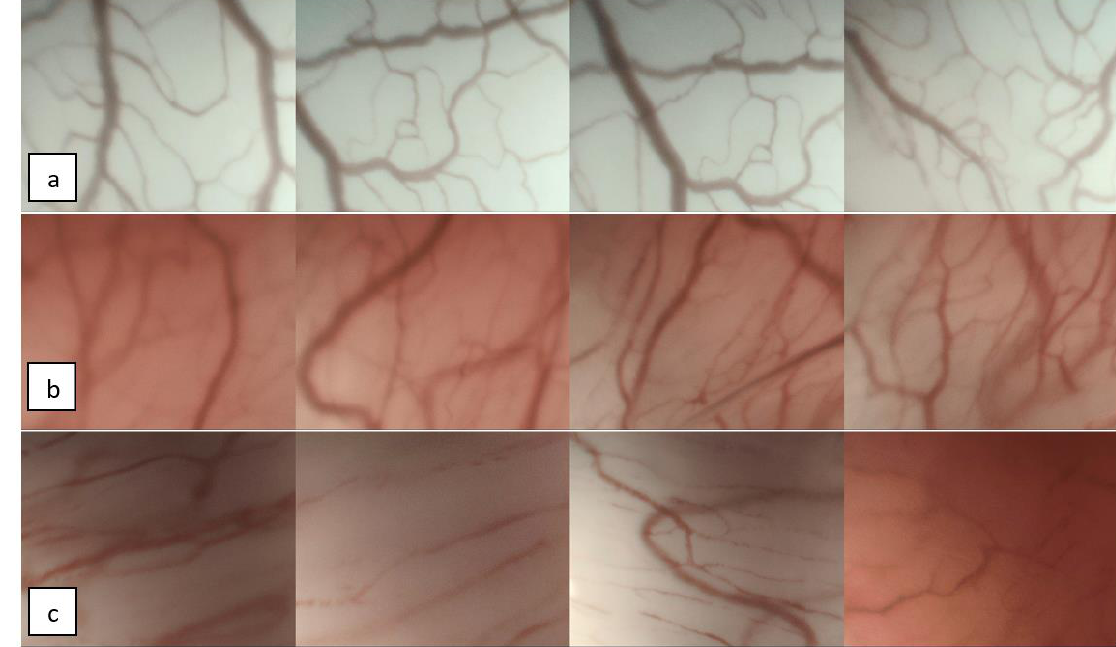
Figure 2. Examples of PVC-negative lesions: series of NBI-CE images depicting longitudinal vascular changes (LVC). Histological diagnoses: ( a ) Reinke’s edema, ( b ) cyst, and ( c ) nodule.